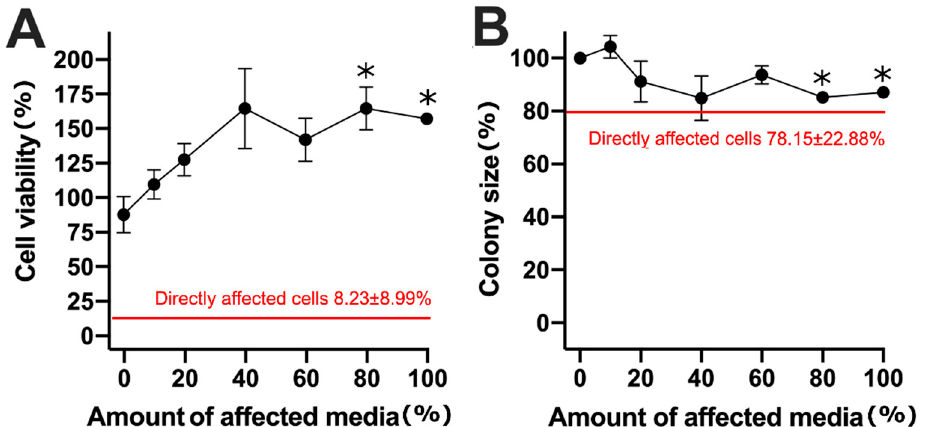
Figure 4. Cell viability ( A ) and cell colony size ( B ) changes after cell growth in a medium containing different ratios of the affected medium. The affected medium was taken from cells that were irreversibly electroporated by using one 2800 V/cm, 100 µs pulse. The red lines and black curve represent directly and indirectly affected cells, respectively. The * symbol represents statistical significance of p < 0.05 compared to the control.